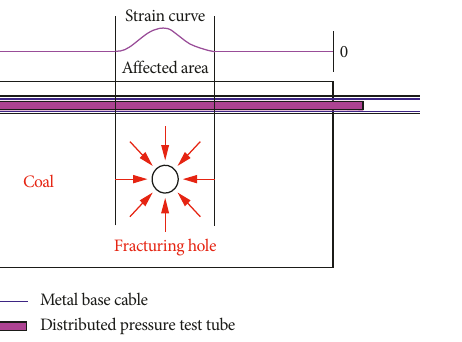
Figure 8: Test principle diagram of pressure relief influence range.